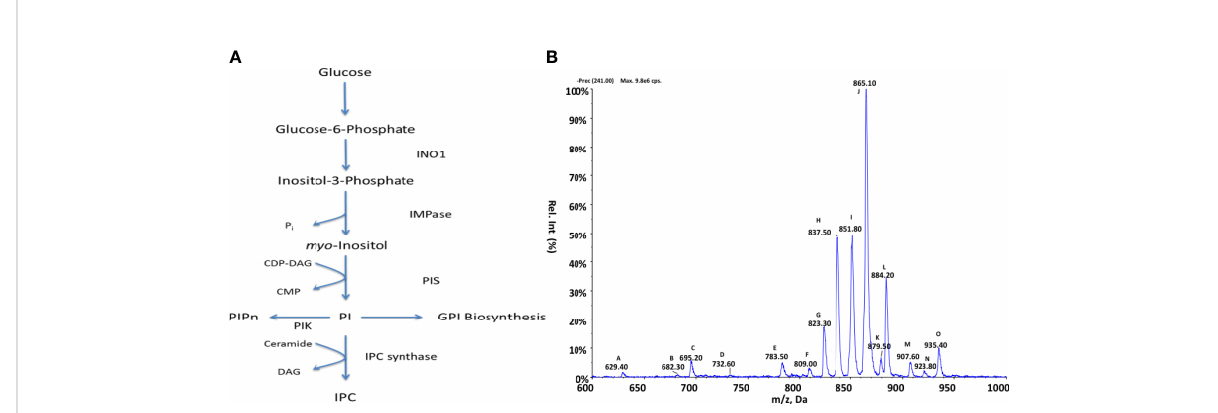
FIGURE 2 Inositol metabolism in Crithidia (A) An overview of inositol metabolism in kinetoplasts. (Key – INO1, Inositol-3-phosphate synthase; IMPase PIK, Phosphatidylinositol kinase; PIS, Phosphatidylinositol synthase; IPC synthase, Inositol phosphorylceramide synthase; PIPn, Phosphatidylinositol phosphate; CDP-DAG, cytidine diphosphate-diacylglycerol; CMP, cytidine monophosphate; IPC, phosphorylceramide.) (B) ESI-MS-MS negative parent ion scan of PI lipids from C. fasiculata lipid extract, scanning for m/z 241. Peaks are plotted as their relative intensity (%) to that of the largest peak in the spectrum and in terms of their mass to charge (m/z) ratio. (Species identities are given in Supplementary Table